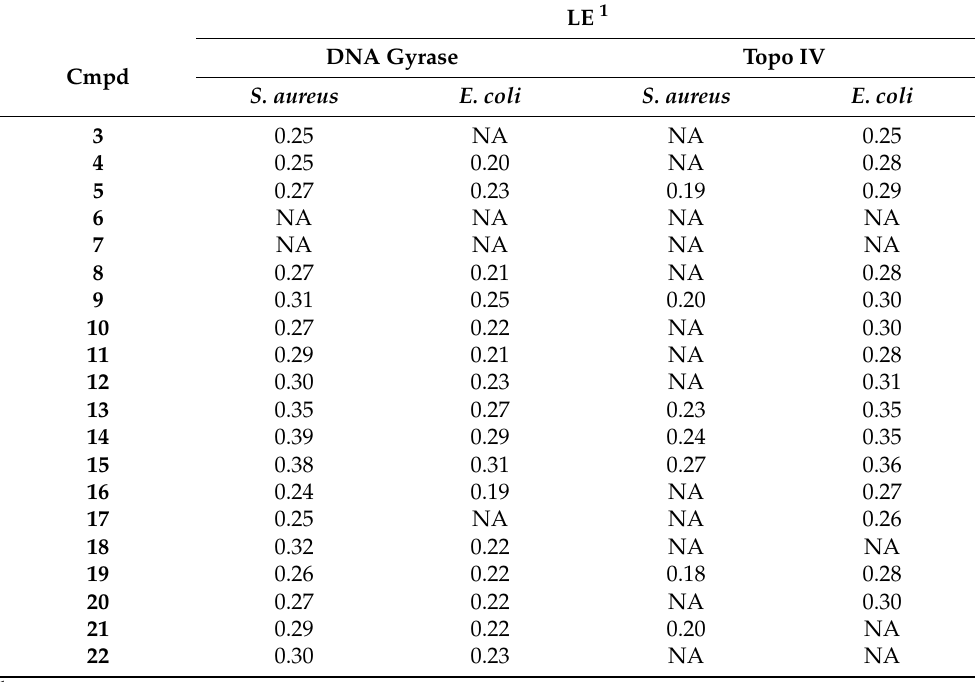
Table 3. Calculated ligand efficiency (LE) values of